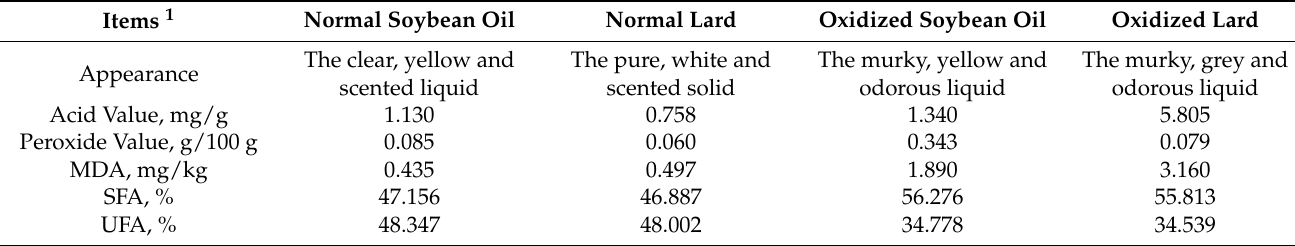
Table 2. The index of different quality lard and vegetable oil.